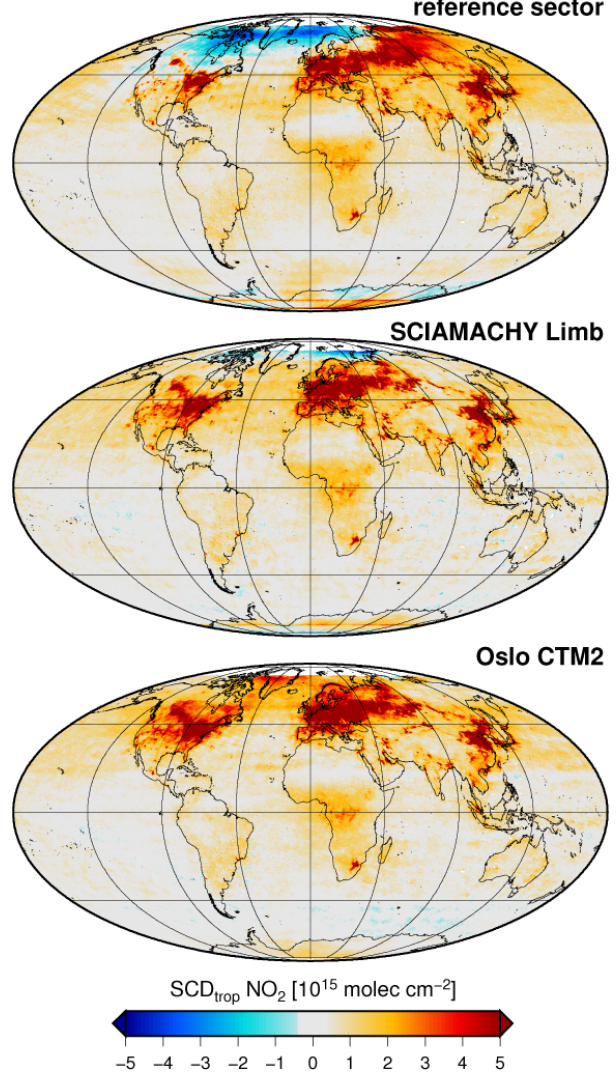
Fig. 17. Monthly average of SCD trop NO 2 from SCIAMACHY for February 2005, using the reference sector method (top), SCIAMACHY limb measurements (centre), and Oslo CTM sim- ulations (bottom) as stratospheric